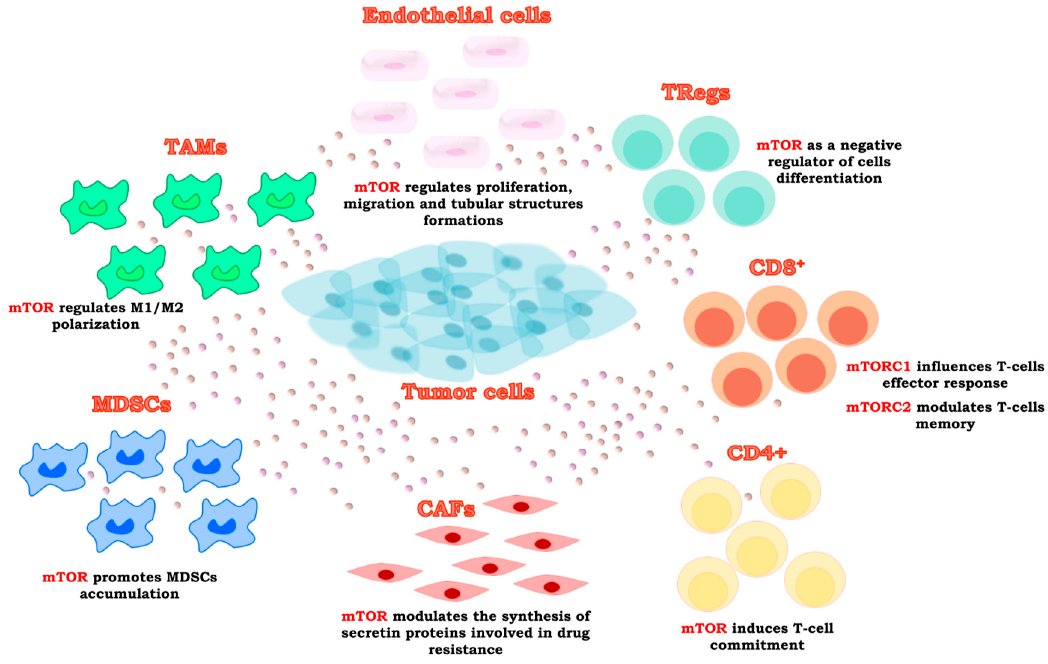
Figure 2. mTOR in characterization and the activity of the tumor microenvironment (TME) elements. mTOR signaling is involved in the modulation of several environmental inputs in TME, mainly composed by regulatory T cells (Treg), CD8 + and CD4 + lympohocytes, myeloid-derived suppressor cells (MDSCs), tumor-associated macrophages (TAMs), endothelial cells, and